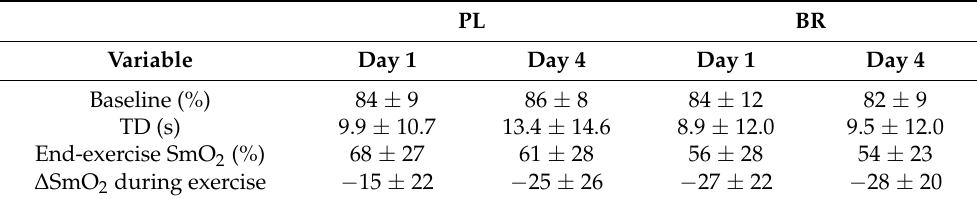
Table 6. Muscle oxygenation of the pectoralis major during a repetitions-to-failure bench press exercise protocol for determination of muscular endurance following acute and multiday nitrate